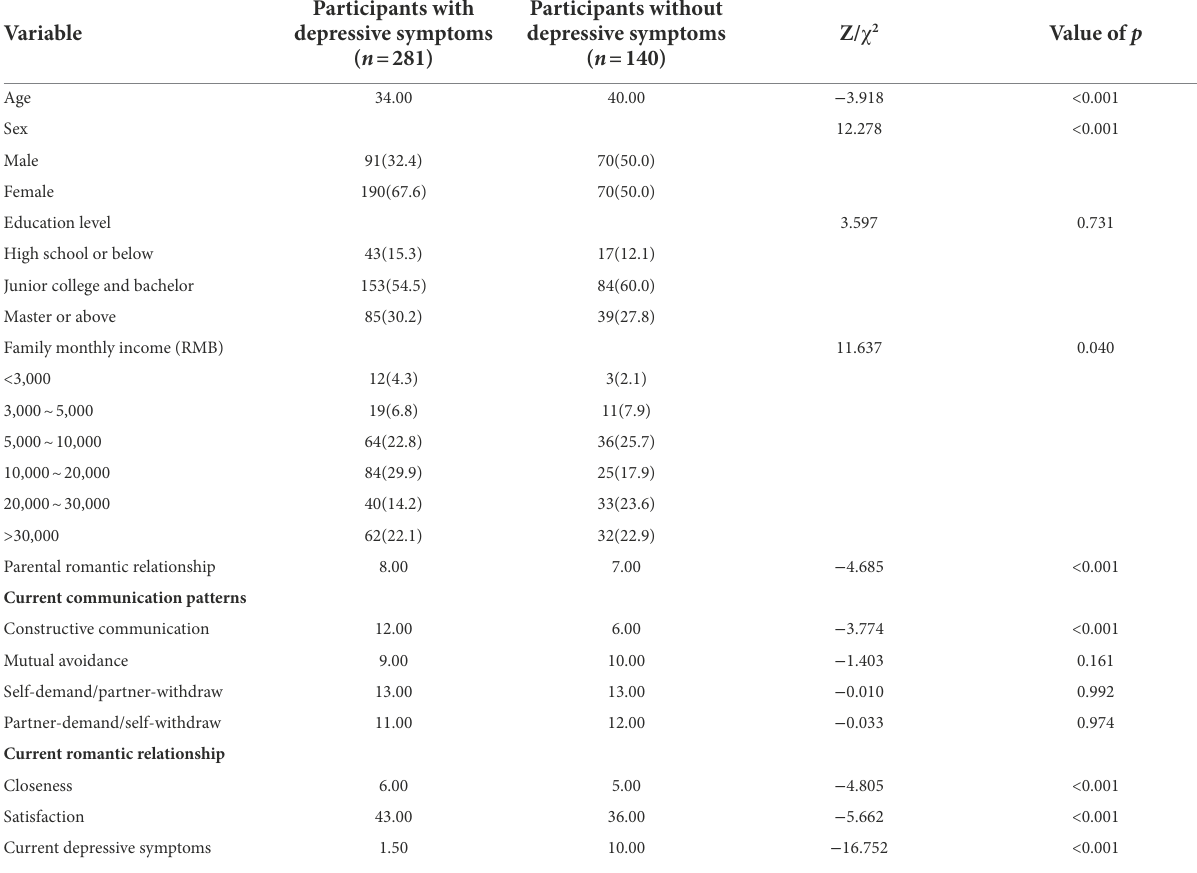
TABLE 2 Sample characteristics of depressed and nondepressed